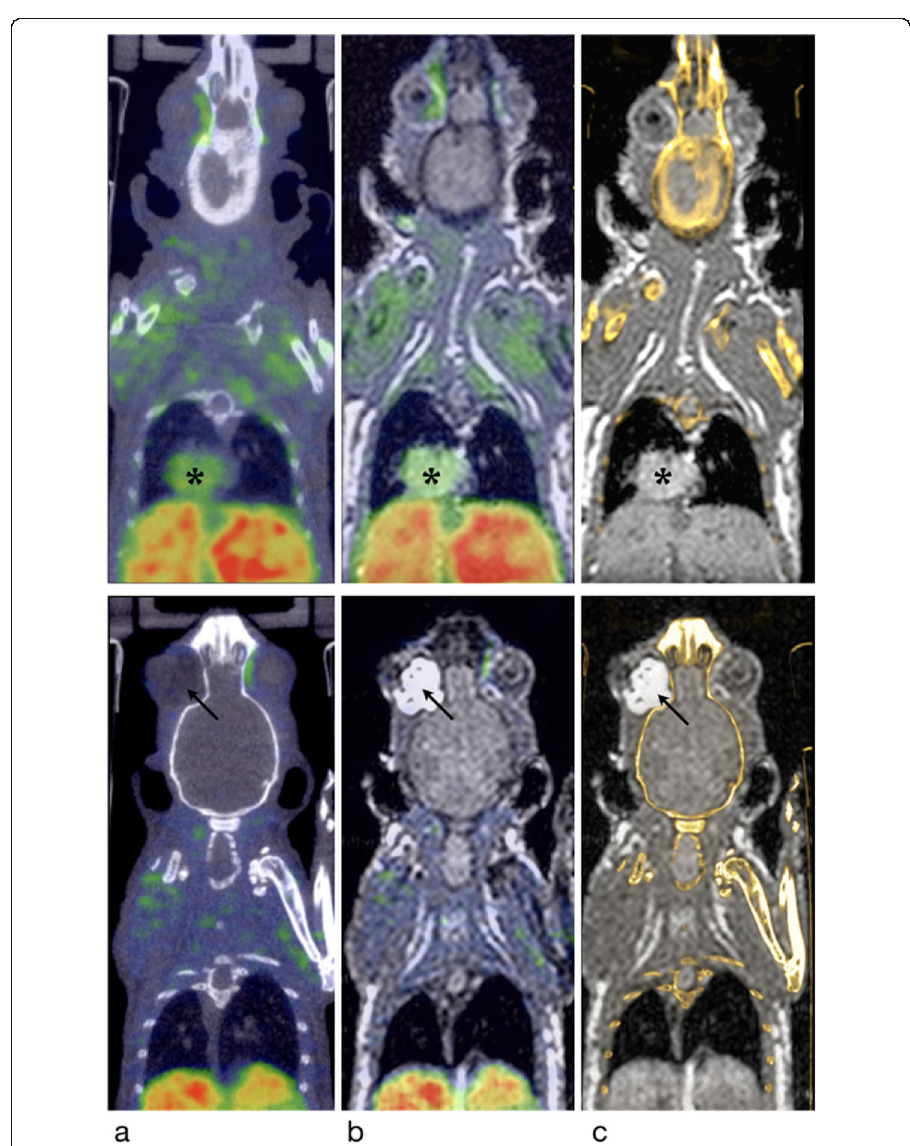
Fig. 3 Coronal slices from a multimodal protocol: 1.5 T MRI (T1w)- μ CT- μ SPECT ( 99m Tc-MIBI) on a mouse (C57BL6) with spontaneous mediastinal tumours (black star) and retro-orbital tumour (black arrow). μ SPECT/ CT ( a ), SPECT/MRI ( b ), and μ CT/MRI ( c )